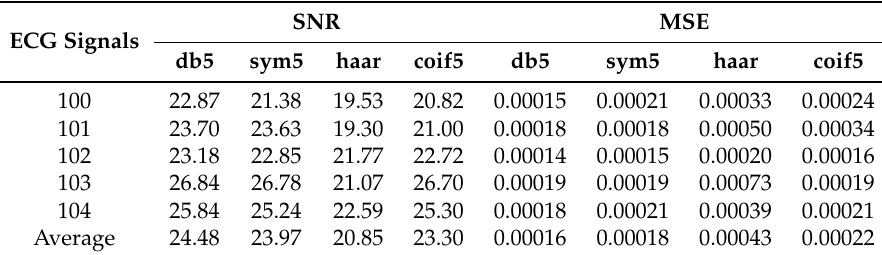
Table 1. Comparison of the de-noising results by several typical wavelet basis.